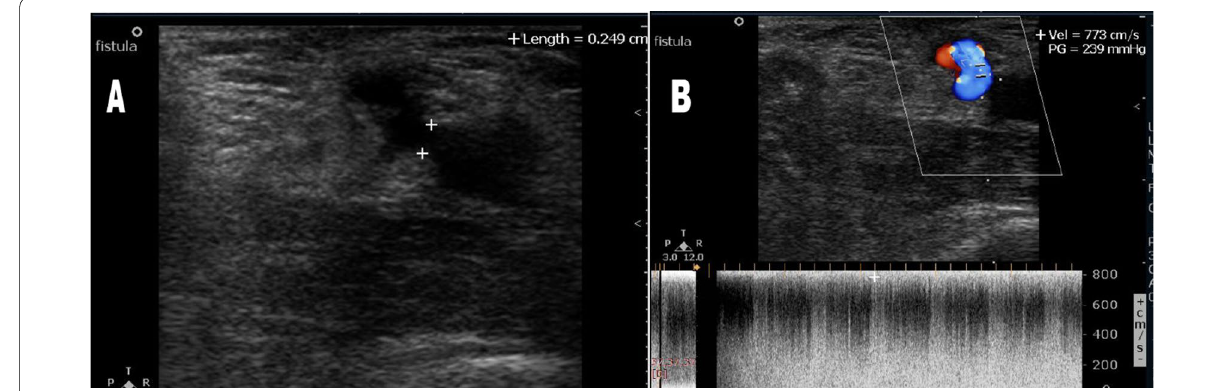
Fig. 2 Fistula stenosis. A Sonographic examination of the fistula revealed reduced diameter (0.249 cm). B Color Doppler examination of the fistula showed high PSV 773